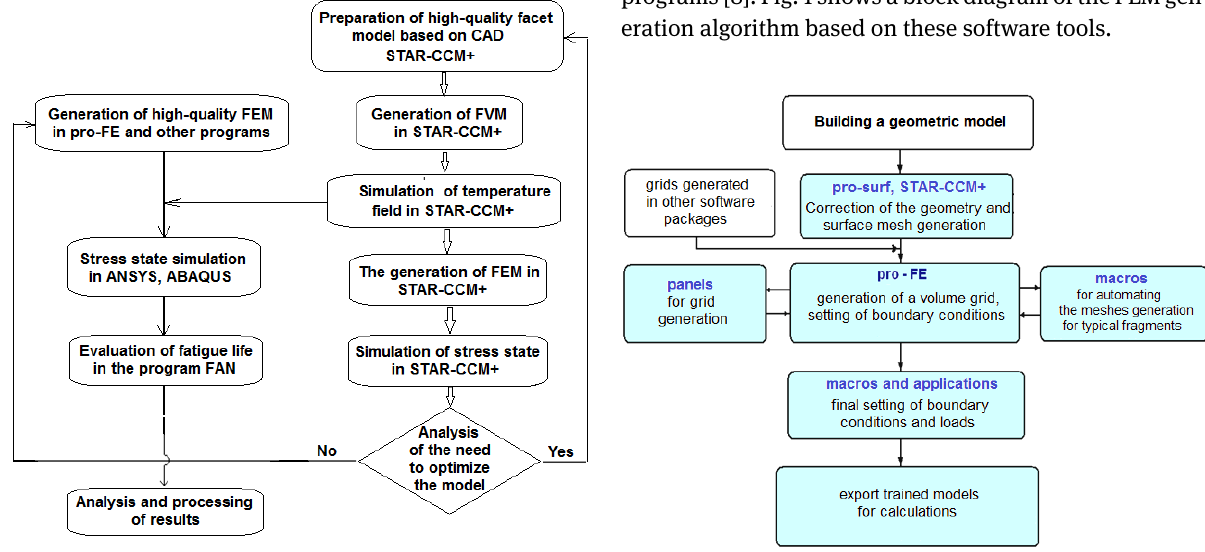
Figure 1: A block diagram of the calculation process using the pre- sented technology